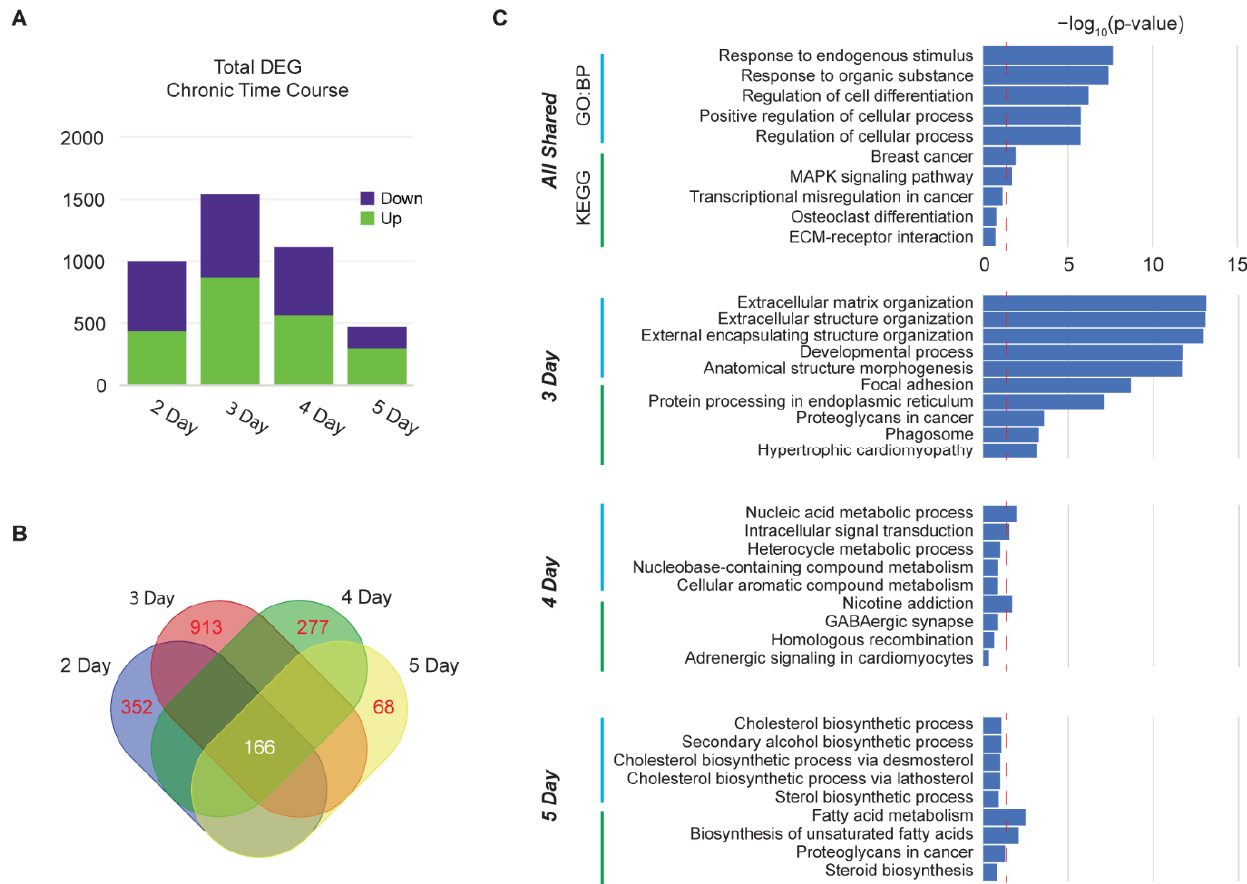
Figure 4. Time course of chronic dopamine administration reveals peak in DEGs at day 3 and desensitization at day 5. ( A ) Total number of DEGs from RNA-seq of DIV50 hMSN-like cells 1 h after 2, 3, 4, or 5 days of daily dosing of 1 mM dopamine. ( B ) Venn diagrams showing shared (white) and unique (red) numbers of DEGs between hMSN-like cells dosed with dopamine for 2–5 days. ( C ) Gene ontology biological processes and KEGG pathways for shared and unique genes from hMSN-like cells dosed with dopamine for 2–5 days. Significance is represented by Log 10 -transformed p -values with dotted red line indicating p -value of 0.05. In all cases, data were obtained from RNA-seq of H9 hMSN-like cells. DEGs were identified by FDR p -value < 0.05. Differential expression was performed against ascorbic acid vehicle control group using the Wald test. n = 2–3 independent